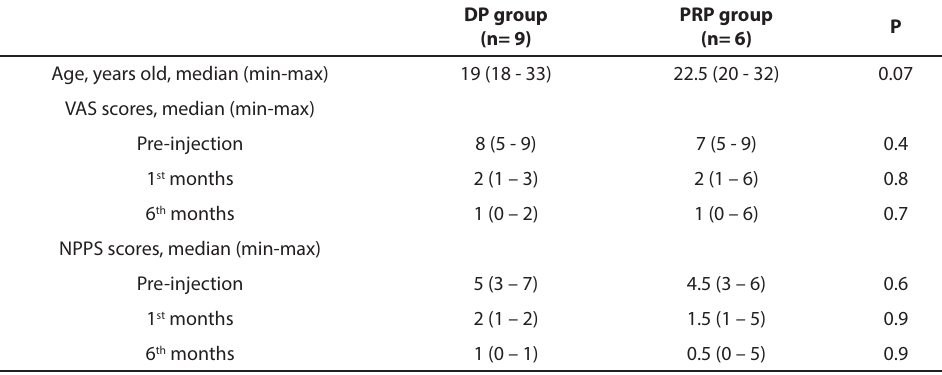
TABLE 1. Age, Visual Analogue Scale (VAS) and Nirschl Pain Phase Scale (NPPS) scores of dextrose prolotherapy (DP) and platelet-rich plasma (PRP)